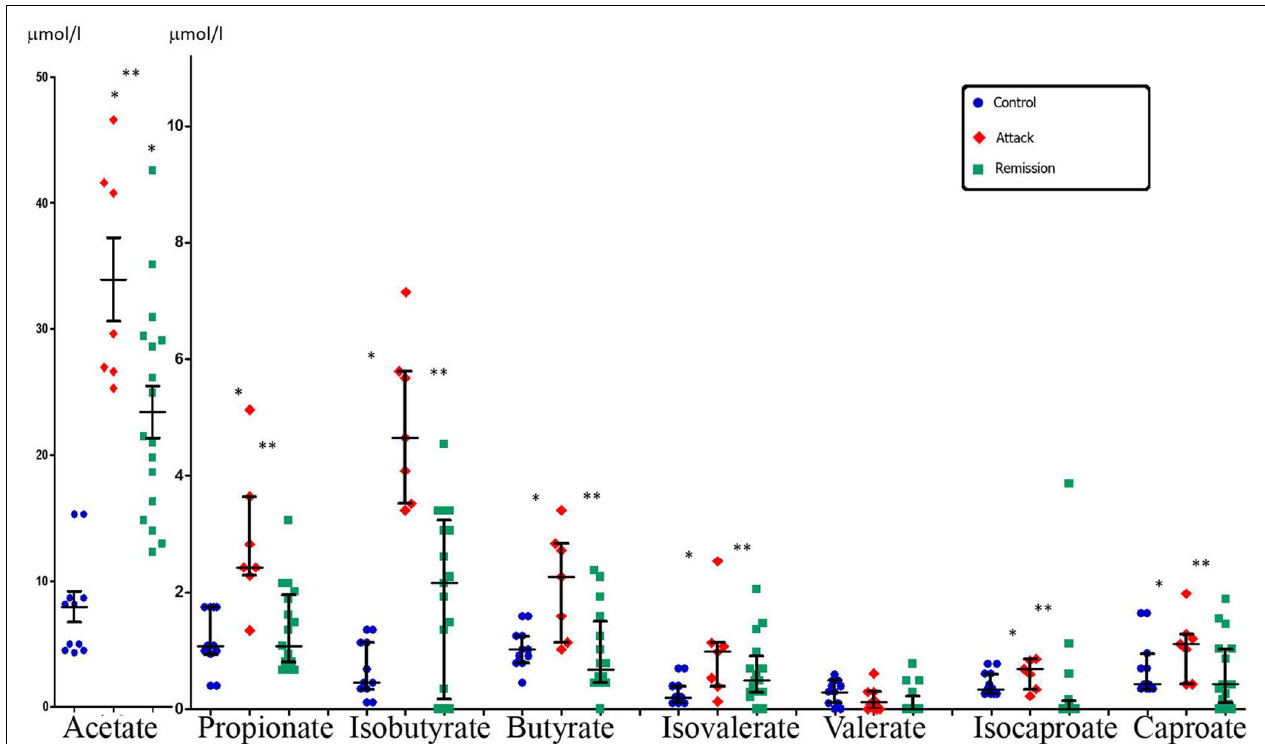
FIGURE 3 | Systemic concentration of SCFAs in FMF patients in attack and remission periods and in control subjects (median with interquartile range). Statistically significant differences in SCFA concentrations: ∗ significant difference between FMF attack and control ( p ≤ 0.05, Mann–Whitney U -test) and ∗∗ significant difference between FMF attack and remission ( p ≤ 0.05, Mann–Whitney U -test). The concentration of acetate is shown in a different